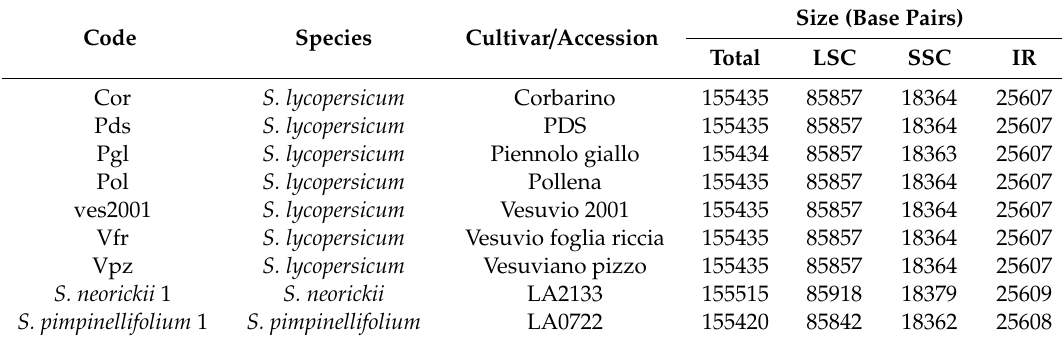
Table 1. Plastome features of the sequenced tomato